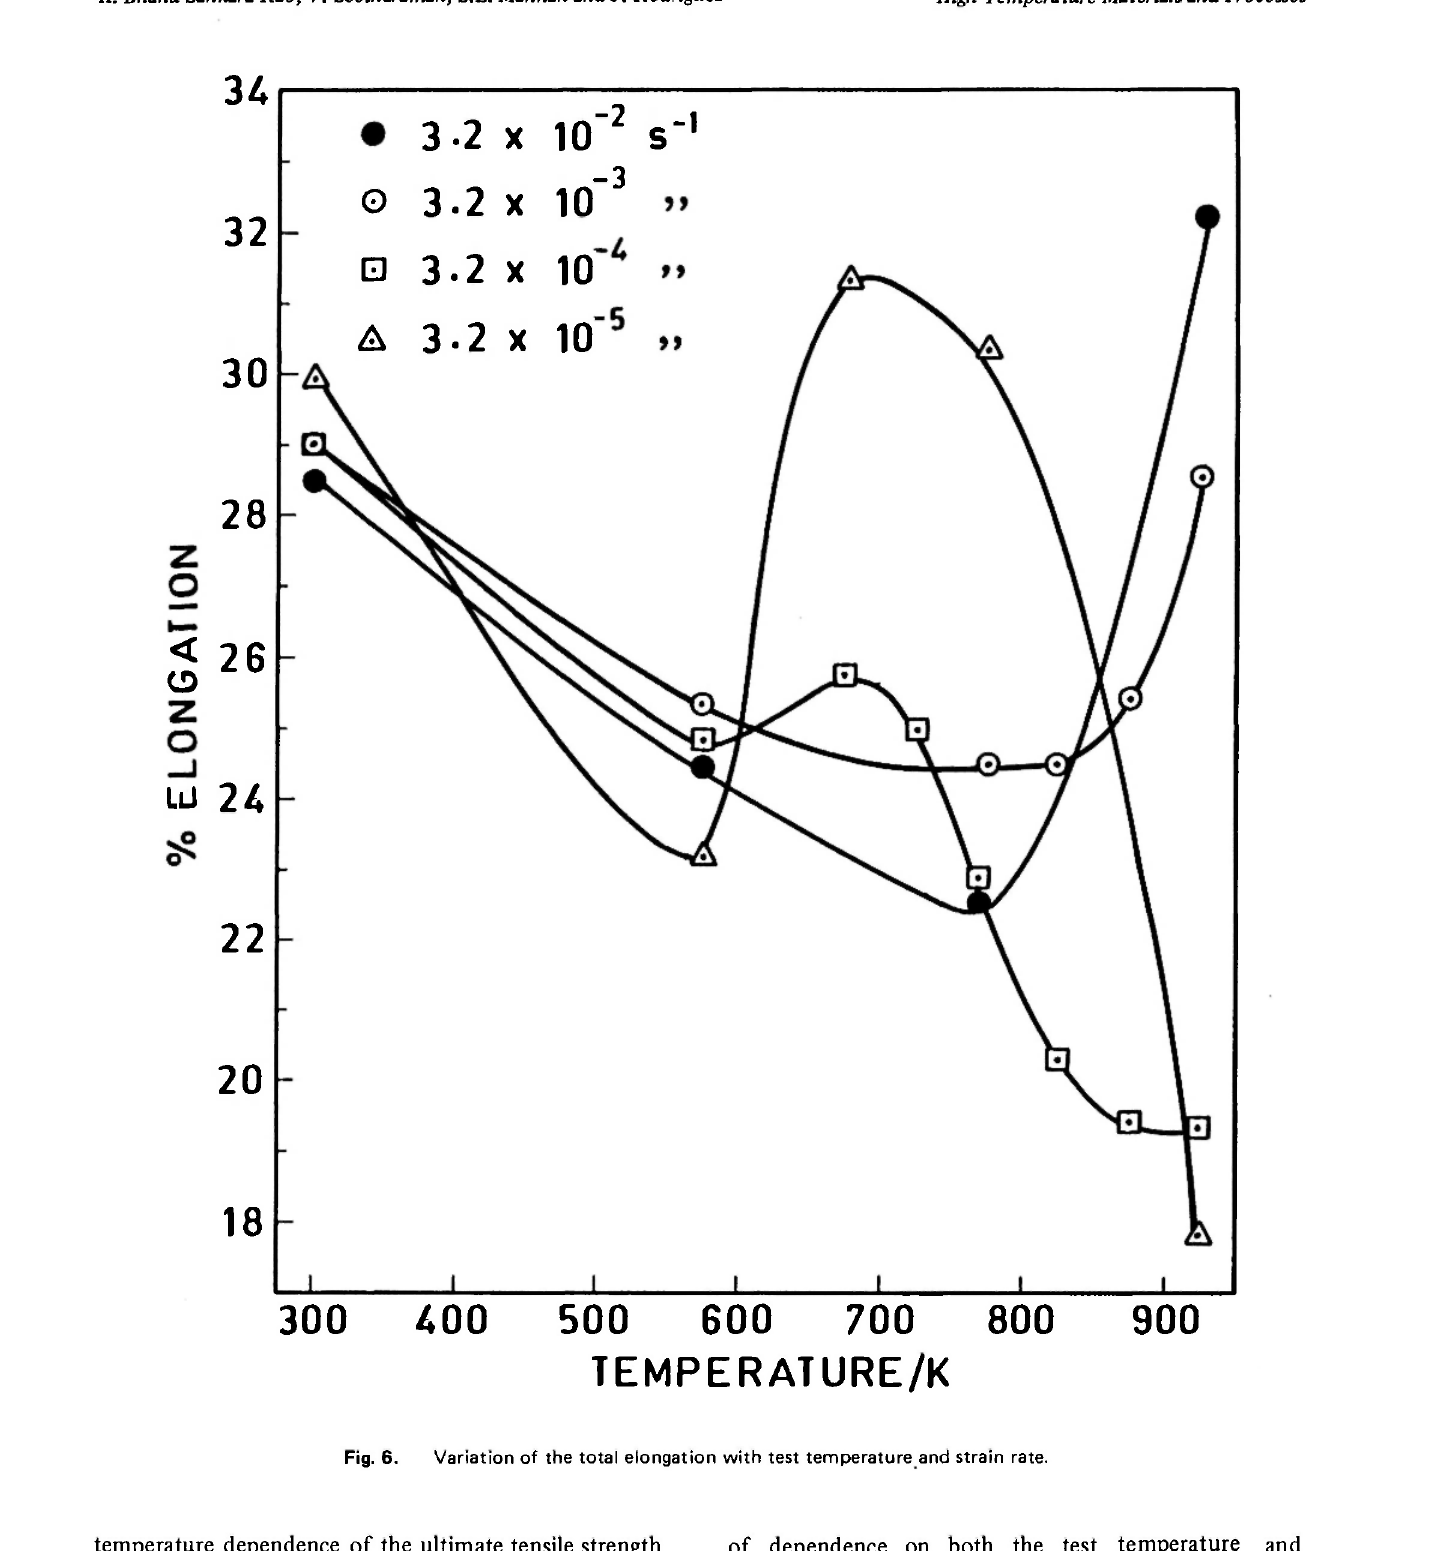
of dependence on both the test temperature and strain rate. For example, the percentage elongation values (Fig. 6) measured at strain rates less than 3.2 X 1(T exhibit minima at 573K and maxima at 673K, whereas those measured at strain rates higher than 3 Χ 10" 3 s" 1 show well-defined minima at